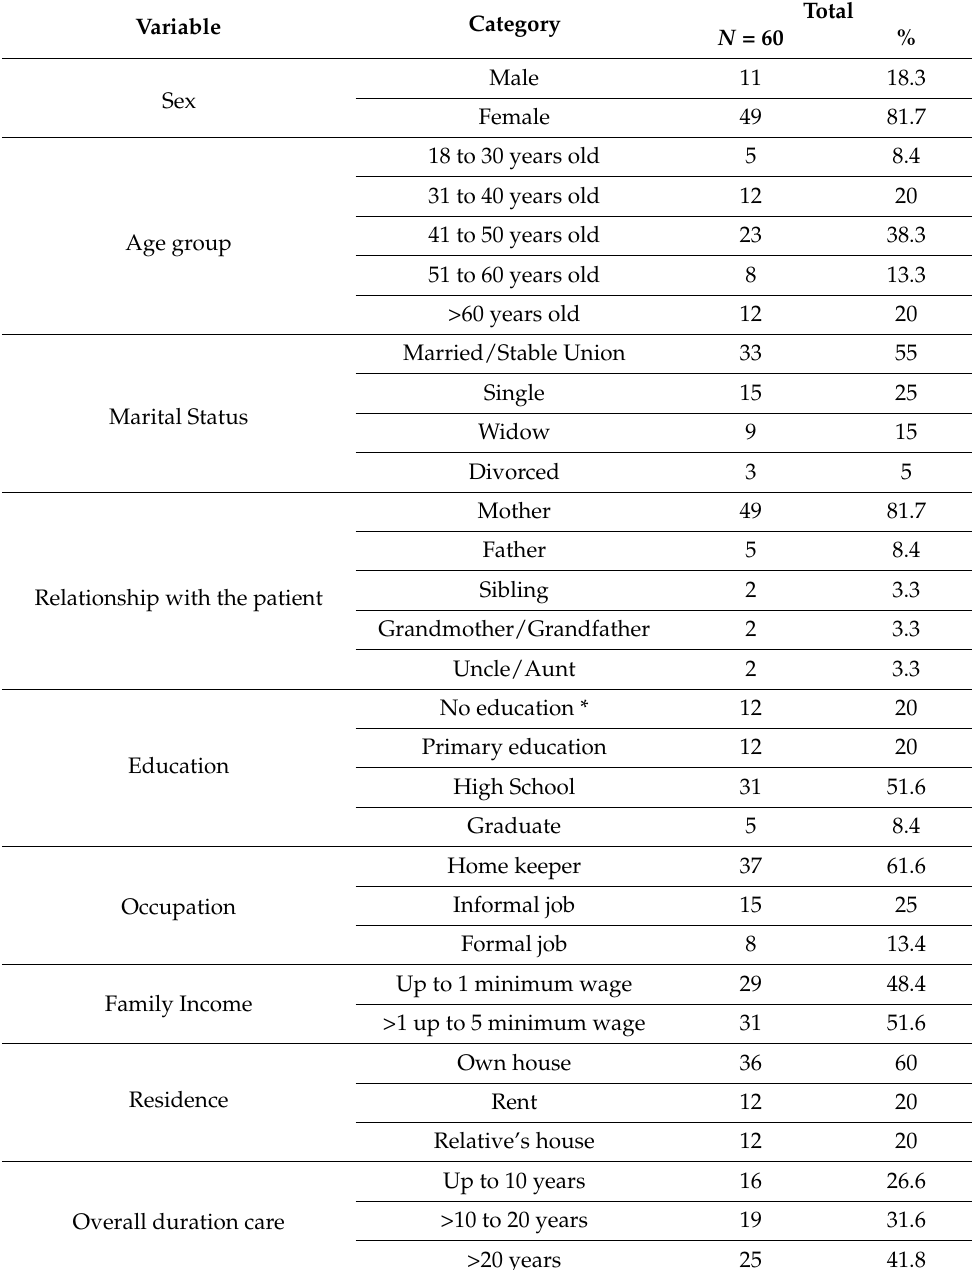
Table 1. Distribution of the study group according to the sociodemographic profile of caregivers.